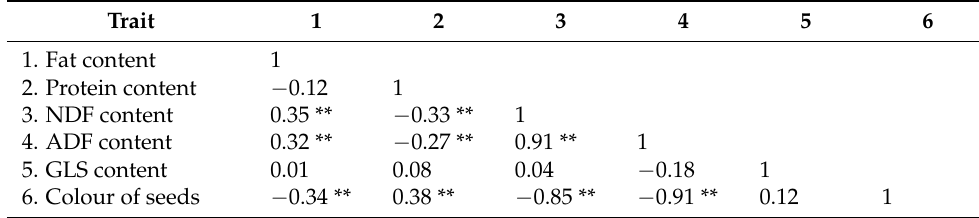
Table 4. Correlation coefficients for the six traits in winter oilseed rape DH lines.